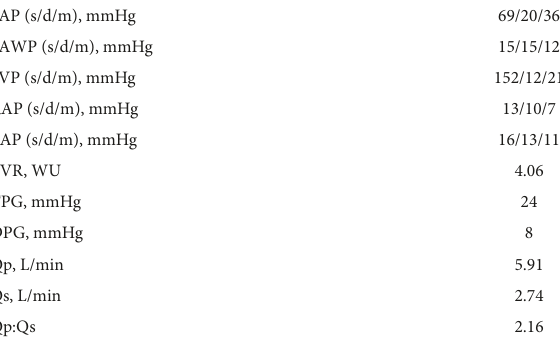
TABLE 1 Right heart catheterization after heart failure control.